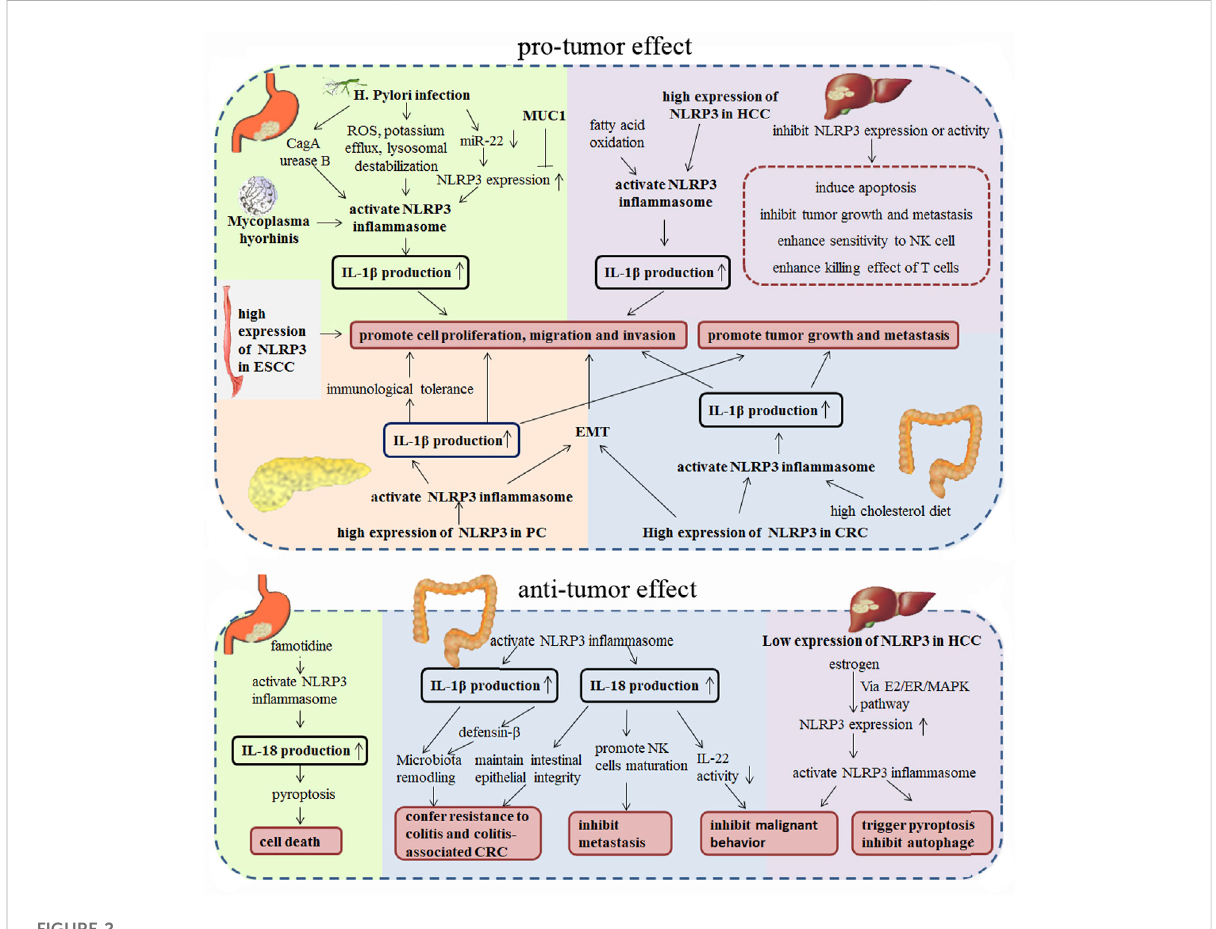
FIGURE 2 Pro-tumor and anti-tumor effect of NLRP3 in digestive system malignancies.